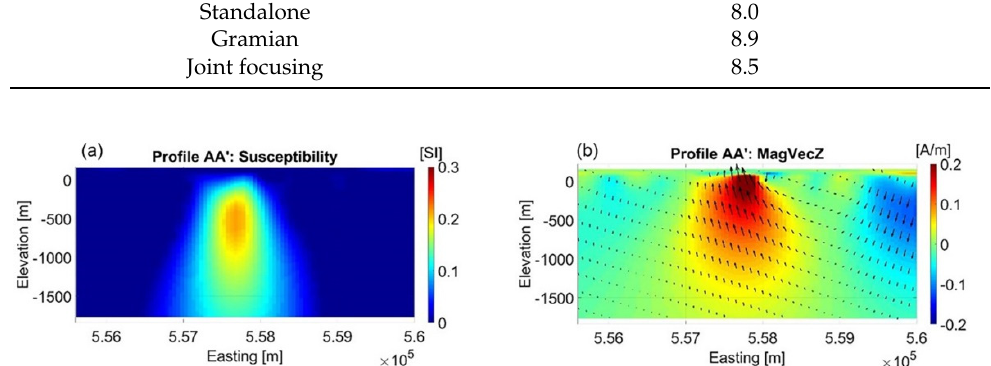
Table 1. Correlation coefficient for different inversion scenarios.